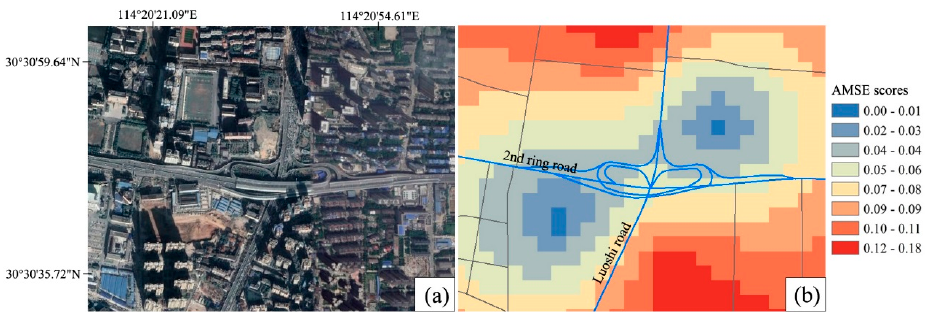
Figure 8. ( b ) A small LVP of AMSE scores occurred near an overpass located at the intersection 2nd ring road and Luoshi road in Hongshan district as t 0 = 10 min; the image in ( a ) was extracted from Google Earth.